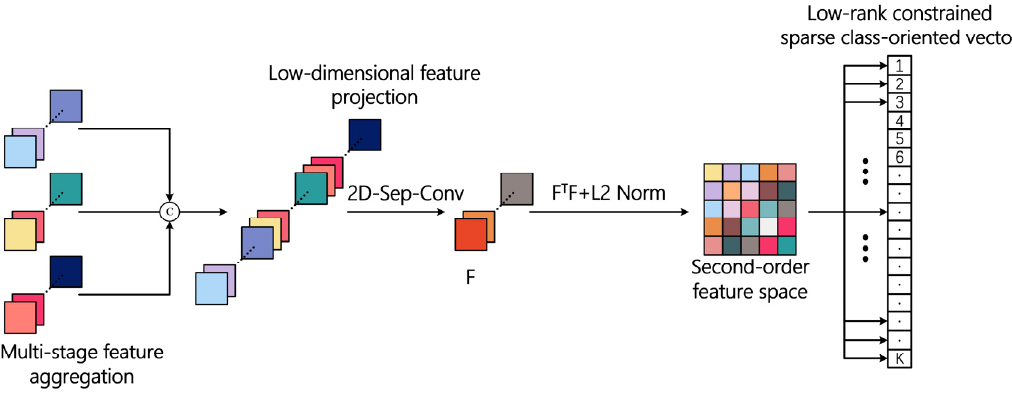
Figure 4. Schematic diagram of low-rank constrained classification based on second-order pooling.